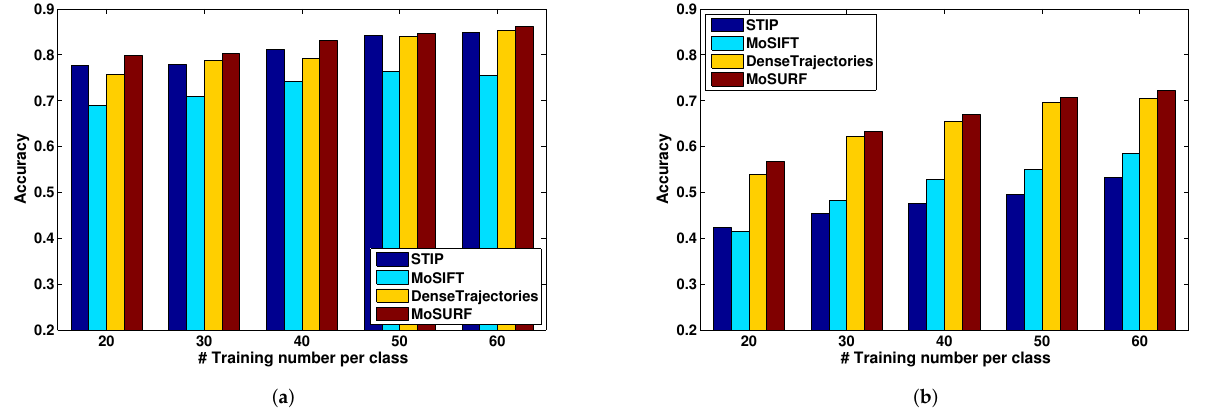
Figure 17. Performance comparison of STIP, MoSIFT, DenseTrajectories, and MoSURF when the num- bers of training videos per class are set to 20, 30, 40, 50, and 60, respectively. For the two datasets, the results are obtained by performing the kNN (k = 10) classifier. ( a ) KTH dataset. ( b ) YouTube